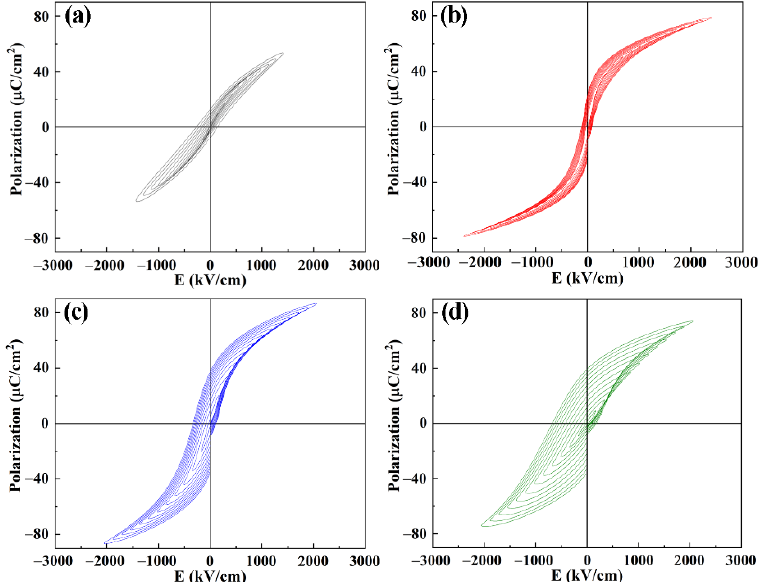
Figure 6. PE hysteresis loops of PMN-PT-xFe thin films with different doping concentration of Fe element ( a ) x = 0, ( b ) x = 2, ( c ) x = 4, ( d ) x = 8. element ( a ) x = 0, ( b ) x = 2, ( c ) x = 4, ( d ) x =